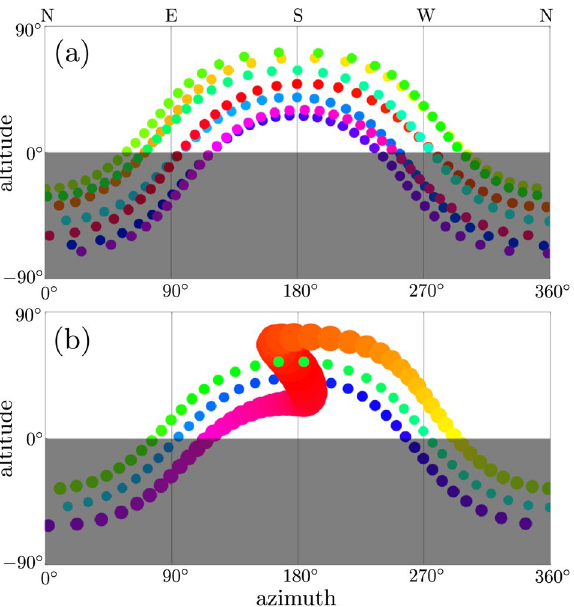
Figure 8. Solar strobe plots. ( a ) Earth-like planet whose sun appears to rise in the east and set in the west every day; rainbow hues code time. ( b ) Mercury-like exoplanet whose sun appears to reverse its motion once a year near periapsis where it appears largest; parameters are eccentricity e = 0.675 , spin–orbit ratio ρ = 1.5 , obliquity ǫ = 23.5 ◦ , nodal longitude (cid:31) = 0 , observer co-latitude θ O = 60 ◦ , and observer longitude φ O = 180 ◦